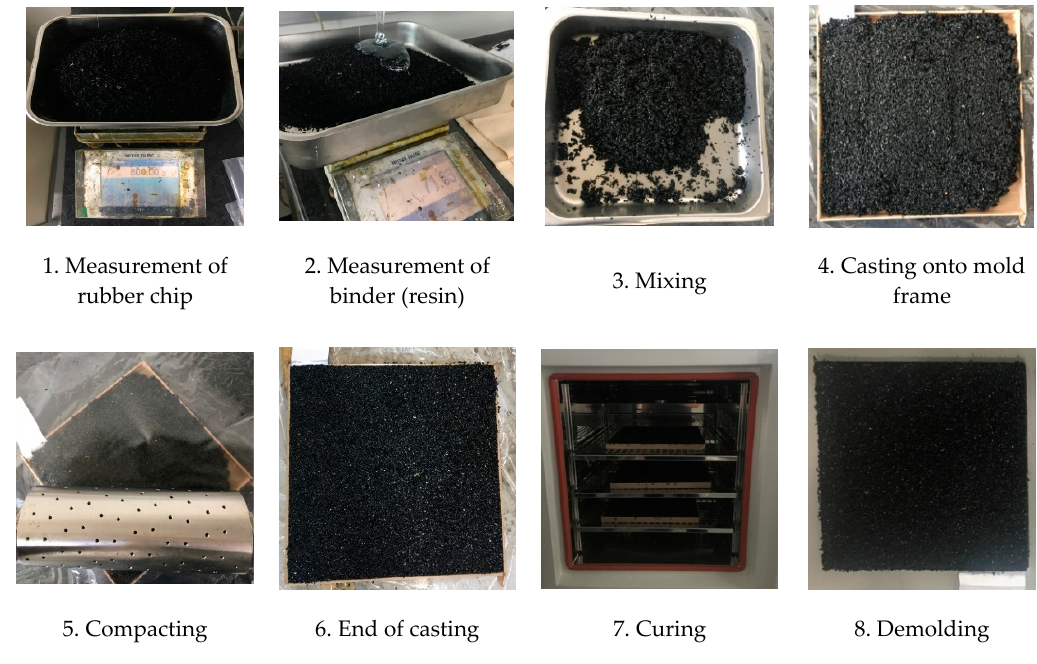
Figure 2. Production process of test samples.